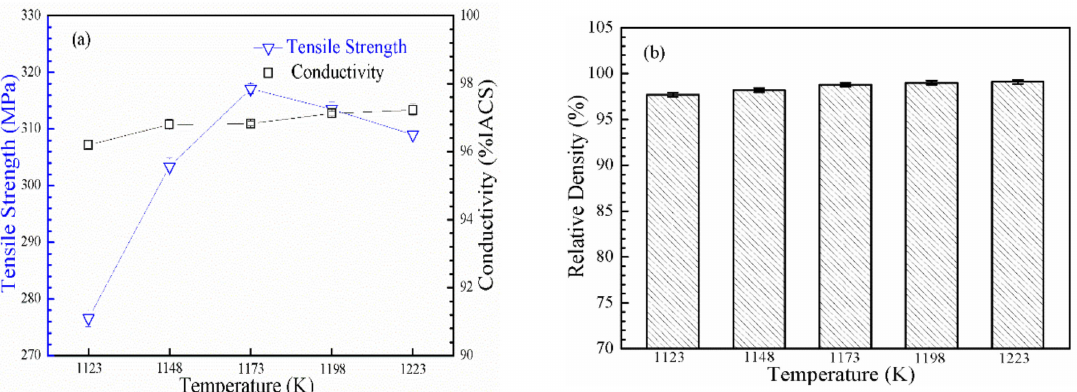
Figure 2. Properties of the nano-Gd 2 O 3 /Cu composite with sintering temperatures ranging from 1123 to 1223 K ( a ) tensile strength and conductivity; ( b ) relative